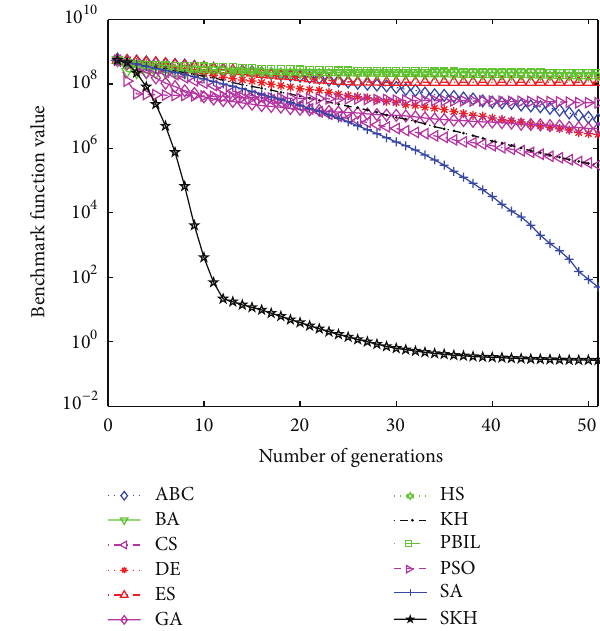
Figure 1: Comparison of the performance of the different methods for the F01 Ackley function.